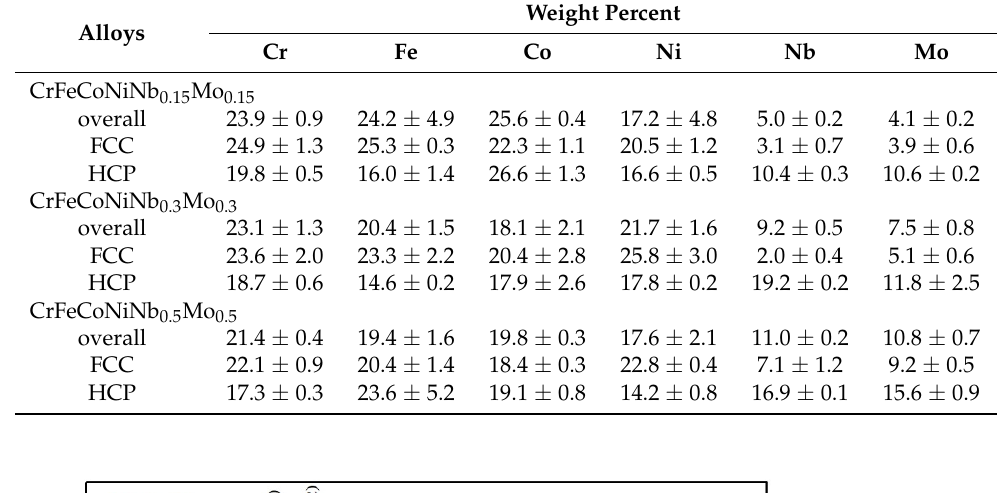
Table 2. The chemical compositions of the as-cast CrFeCoNiNb x Mo x alloys and the phases in each alloy analyzed by SEM/EDS.